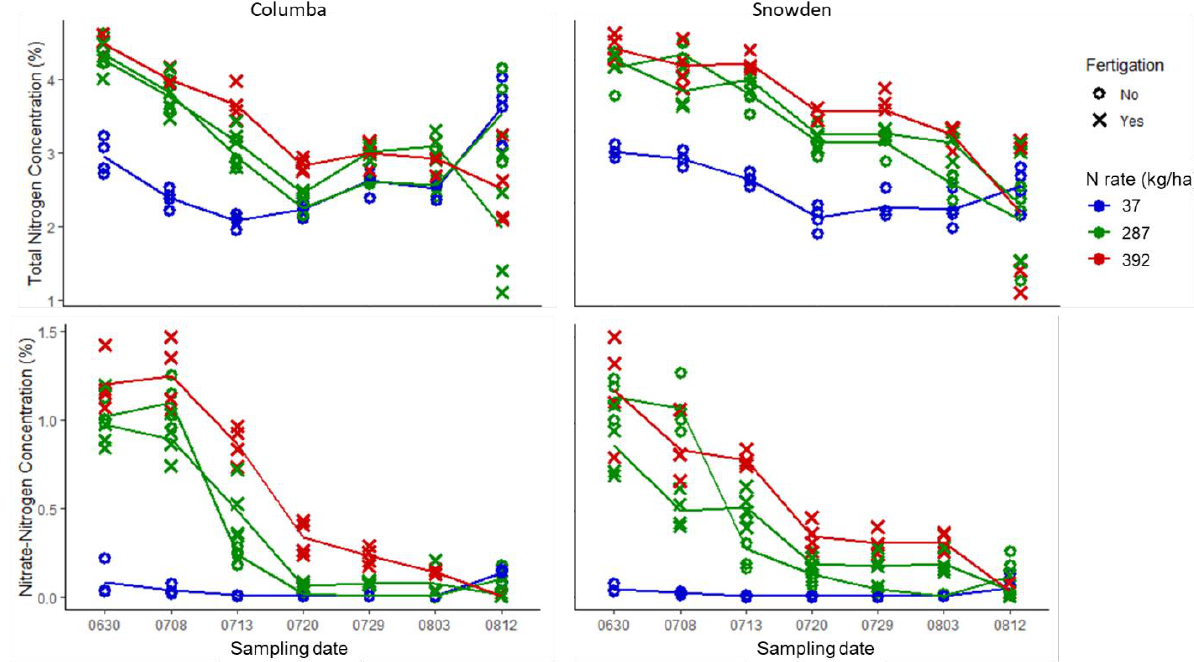
Figure 2. Potato leaf total N concentration and petiole nitrate-N concertation over the growing season for two varieties under different N treatments.